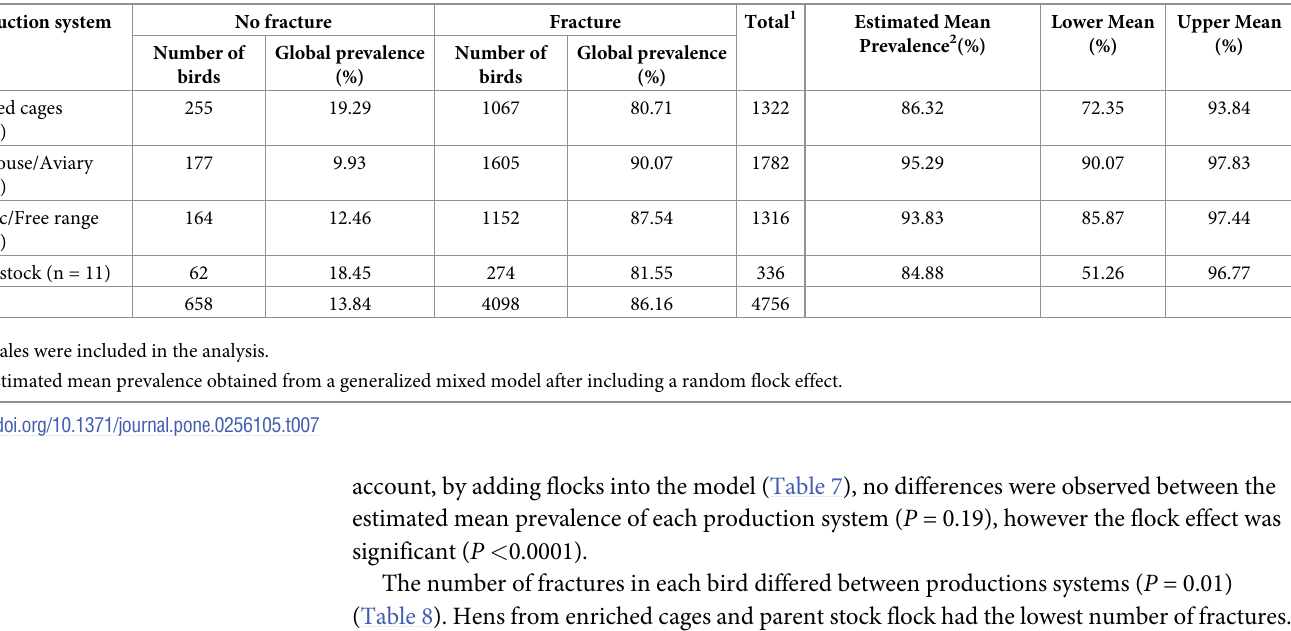
Table 7. Global and estimated mean prevalence of KBF within in production